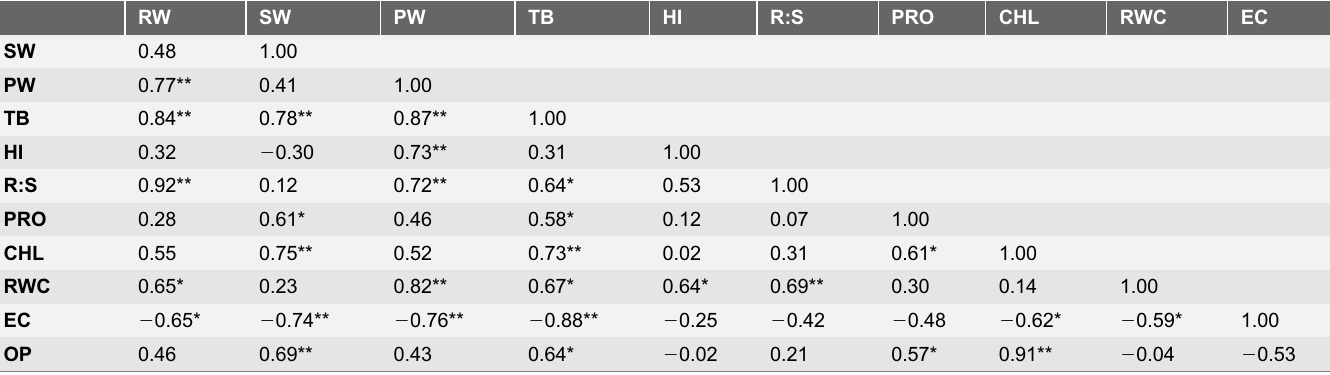
Table 7. Correlation coefficient (r) between different growth- and physio-biochemical parameters under 20% PEG after 3 days of treatment.